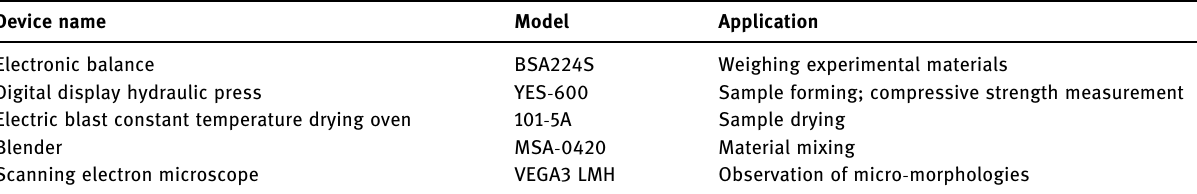
Table 8: Experimental instruments Device